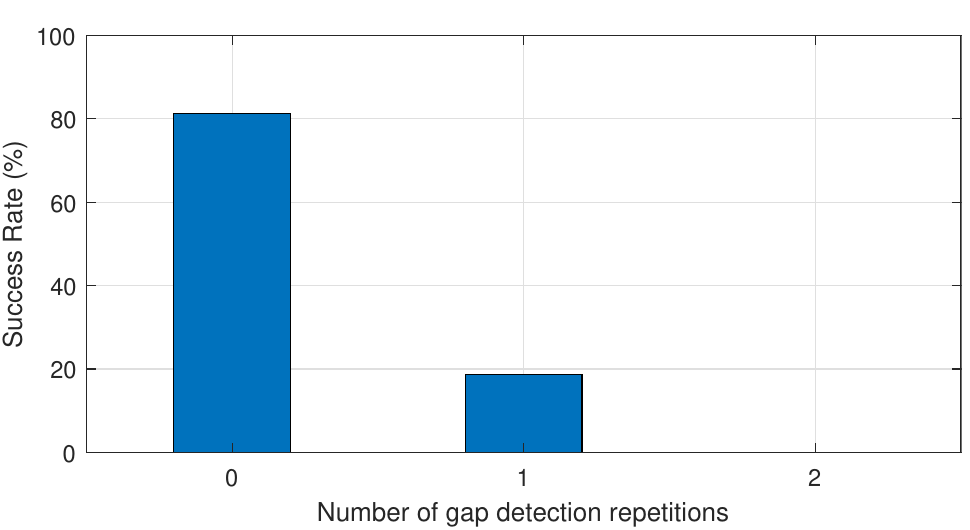
Figure 9. Overall insertion success rate with respect to gap detection